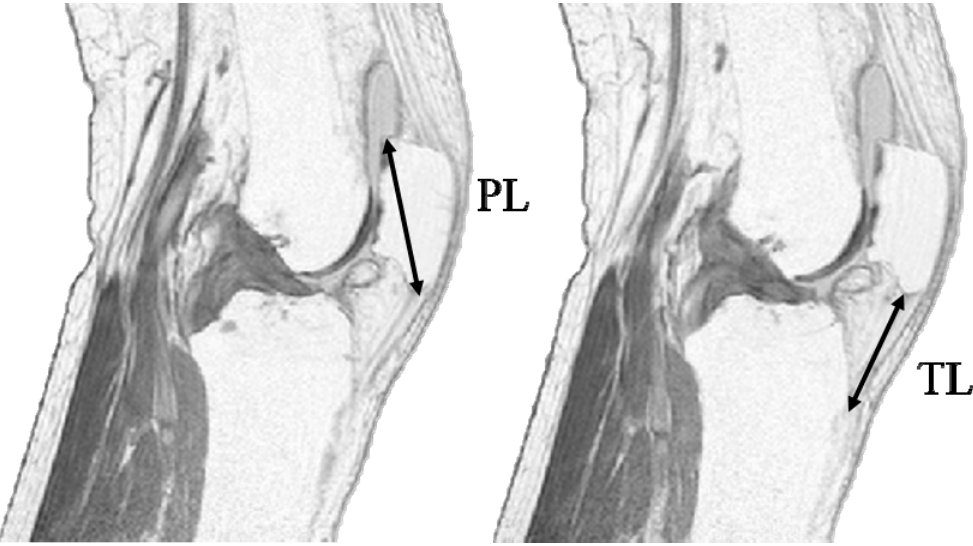
Figure 1. Sagittal T1-weighted magnetic resonance images (MRI): patellar length (PL) and patellar tendon length (TL) measured using Insall–Salvati methods.